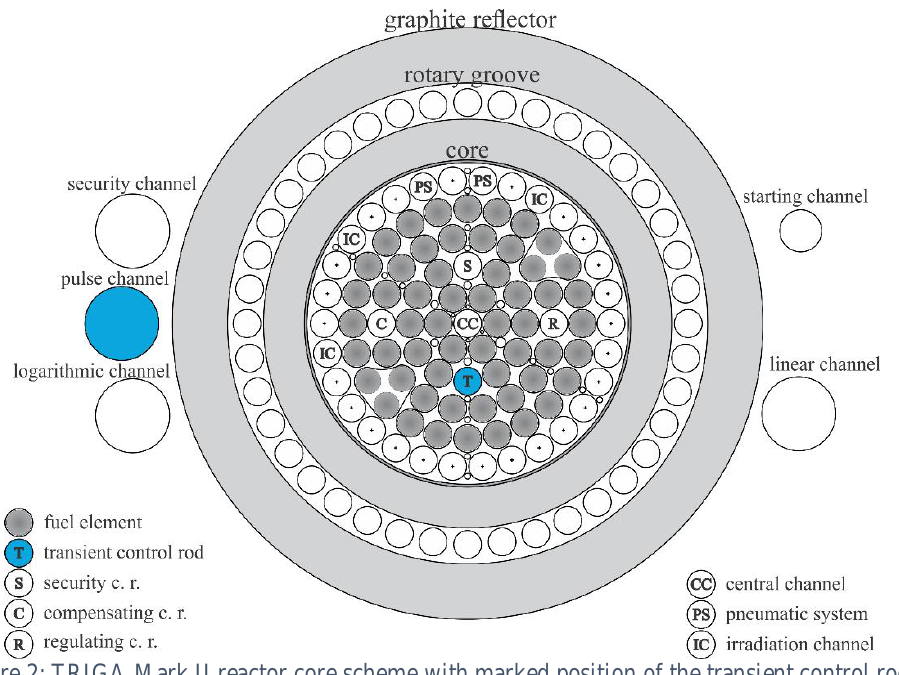
Figure 2: TRIGA Mark II reactor core scheme with marked position of the transient control rod.